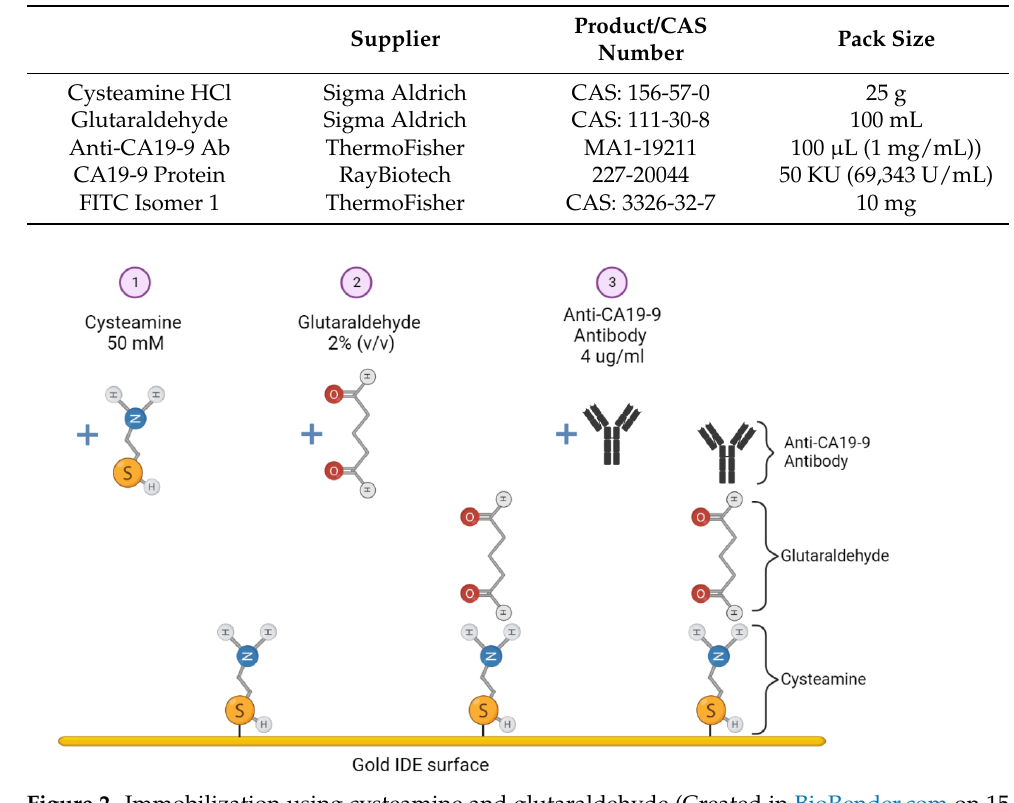
Figure 2. Immobilization using cysteamine and glutaraldehyde (Created in BioRender.com on 15 August 2022 (accessed on 17 August